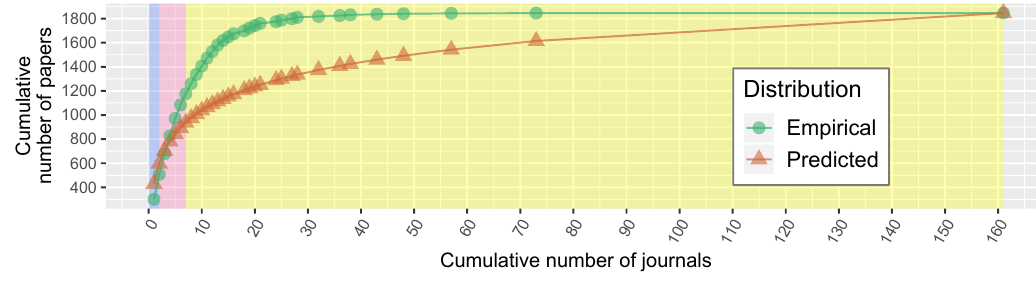
Figure 11. Comparison of Bradford’s law 2:5:154.